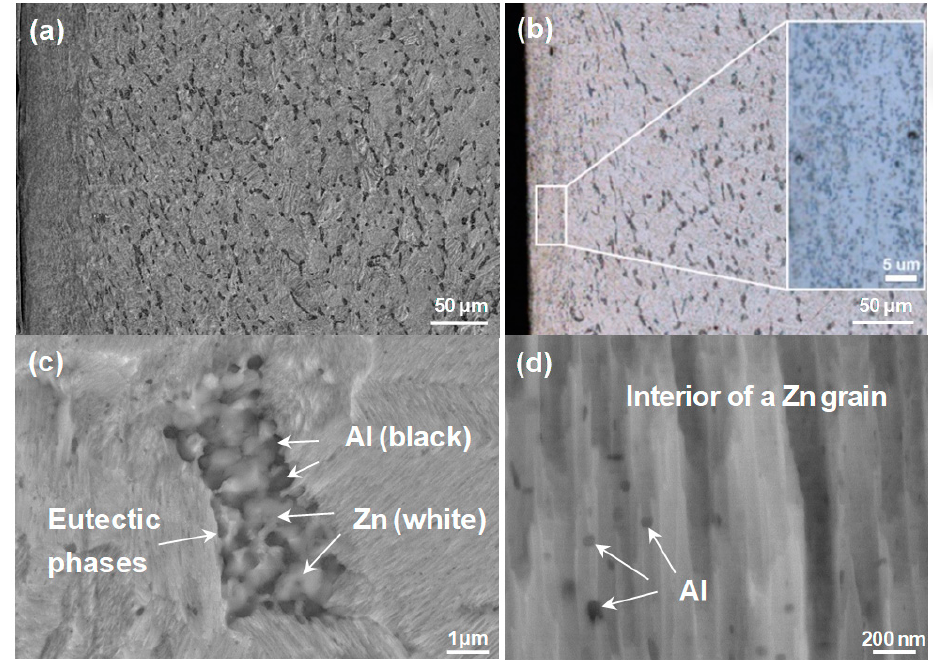
Figure 3. SEM ( a ) and laser confocal microscopy (LCM) ( b ) of the cross profile micrographs in the SFT samples. Magnified images of the eutectic phase ( c ) and the interior of Zn grain ( d ).